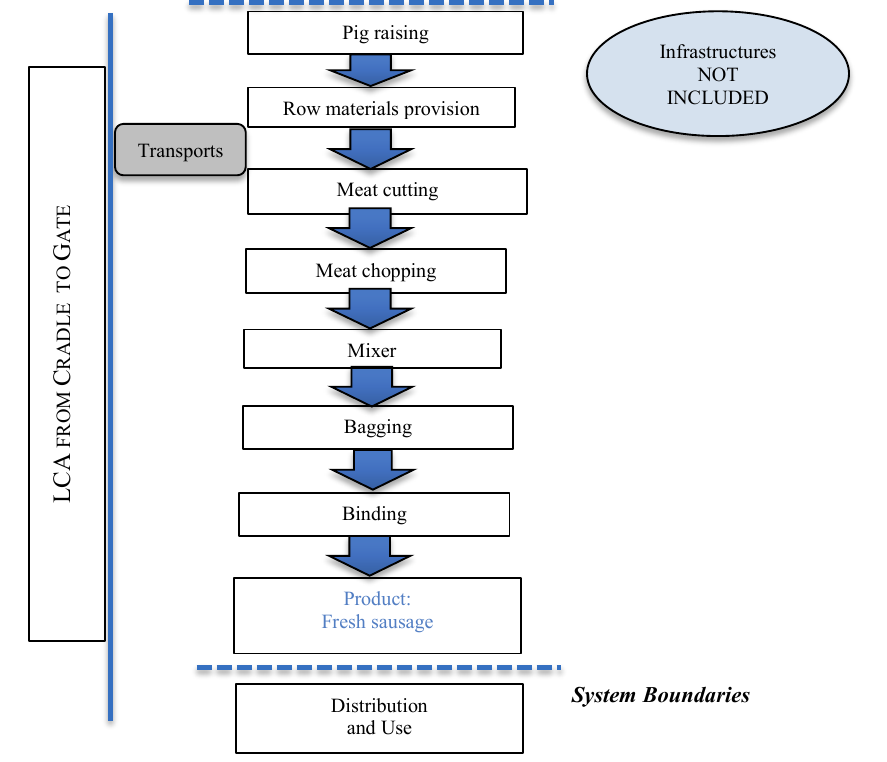
Fig. 1. System boundaries of 100 kg of fresh sausage